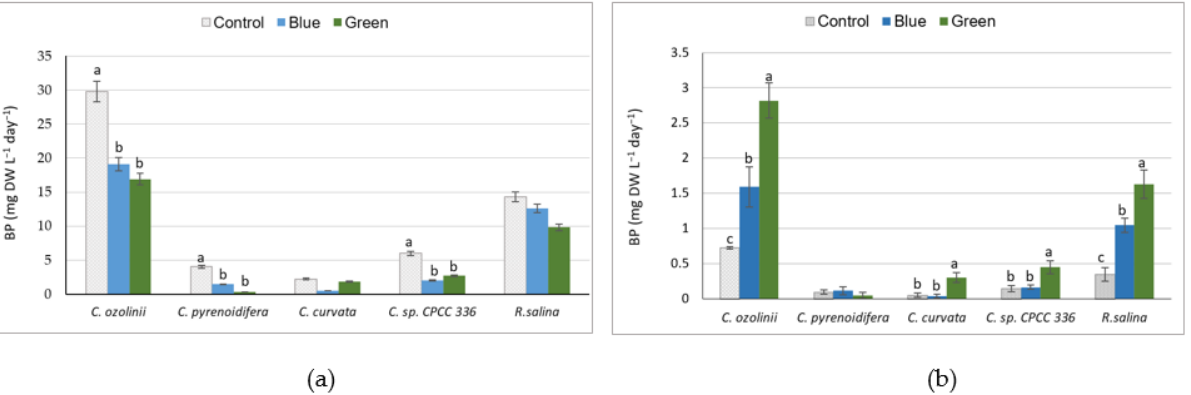
Figure 1. The studied cryptophyte strains were grown under various light conditions (control (white), blue, and green): ( a ) Biomass production (BP; mg dry weight L − 1 day − 1 ); ( b ) biomass production per light unit (µmol photons m − 2 s − 1 ). Significant differences between samples are indicated with different letters as determined by ANOVA comparison ( p < 0.05).